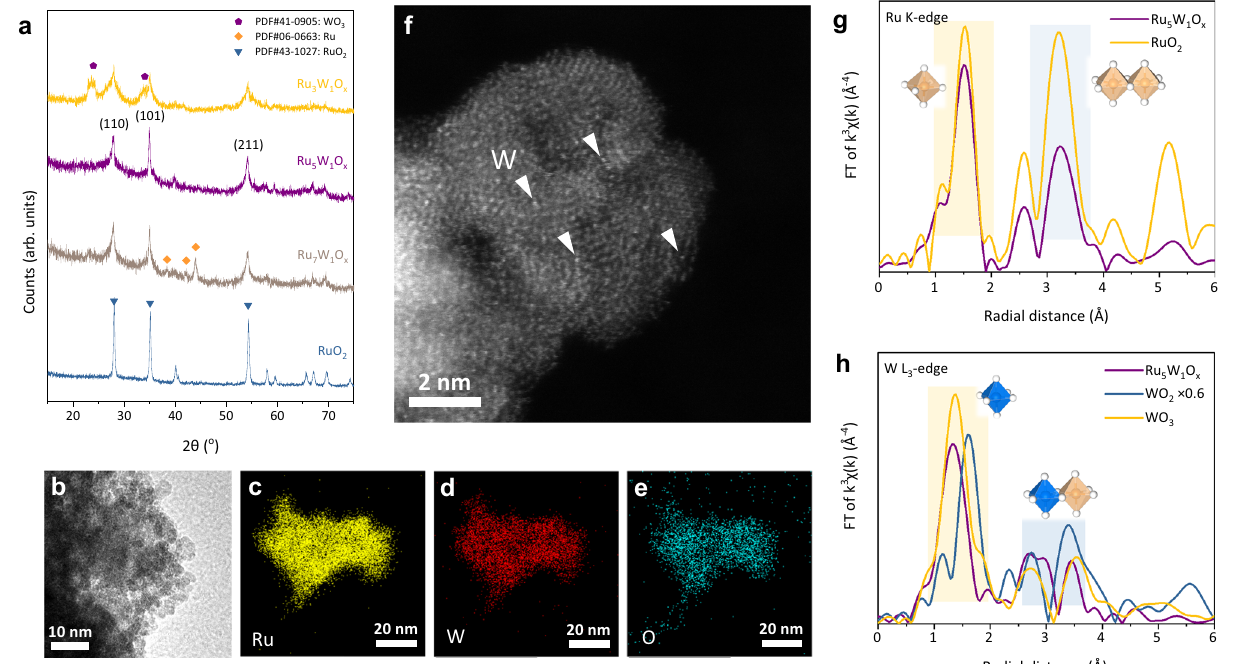
Fig. 1 | Morphology ofRu-W oxides. a The XRD patterns of different catalysts. No peaks from the segregated phases (WO 3 or metallic Ru) were observed in the patternofRu 5 W 1 O x . b TheHR-TEMimageofas-preparedRu 5 W 1 O x catalyst. c – e The EDXelementmappingofRu,W,andO. f TheatomicresolutionHAADF-STEMimage ofRu 5 W 1 O x .ThebrightspotswereWatoms. g , h The k 3 -weightedFT-EXAFSspectra